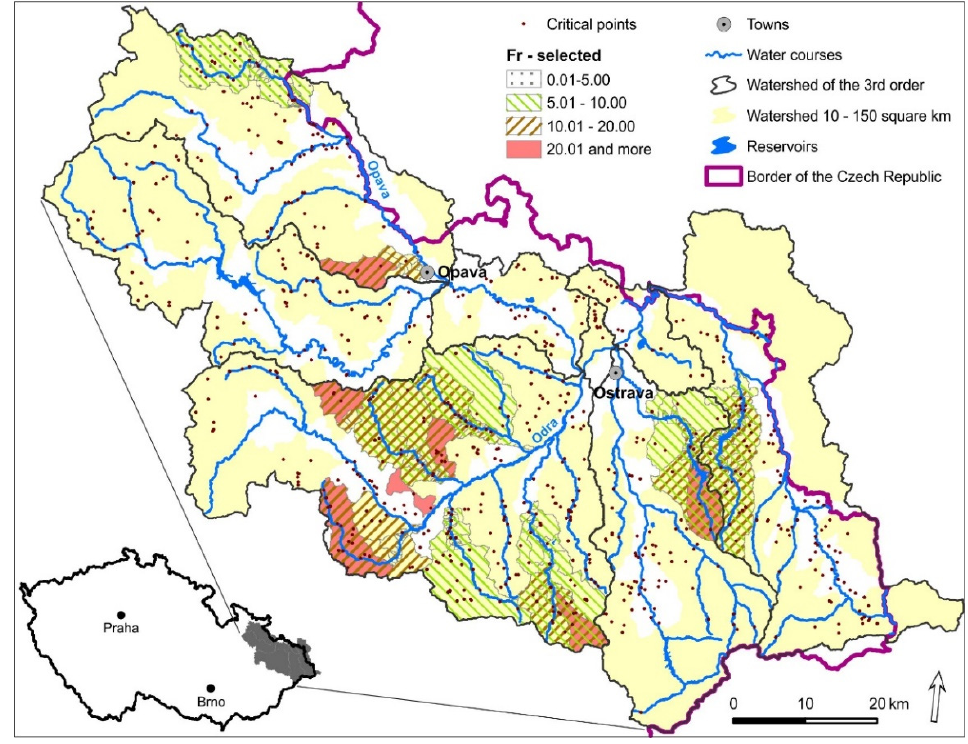
Figure 9. The selection of localities (group of watersheds 201–202–203) according to testing criterion (5). Figures 7 and 9 represent the final selection of hydrological units according to the criterion (5). The selection criterion (red line) in a logarithmic scale, which is shown in Figure 7, can be expressed by Equation